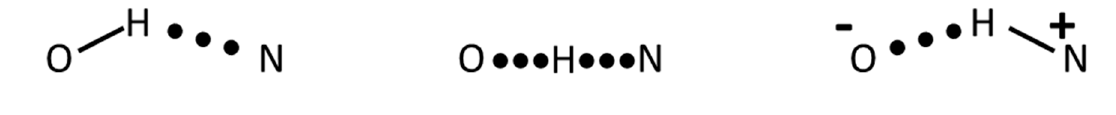
Figure 2. The principal structural stages of proton transfer in the hydrogen bridge.